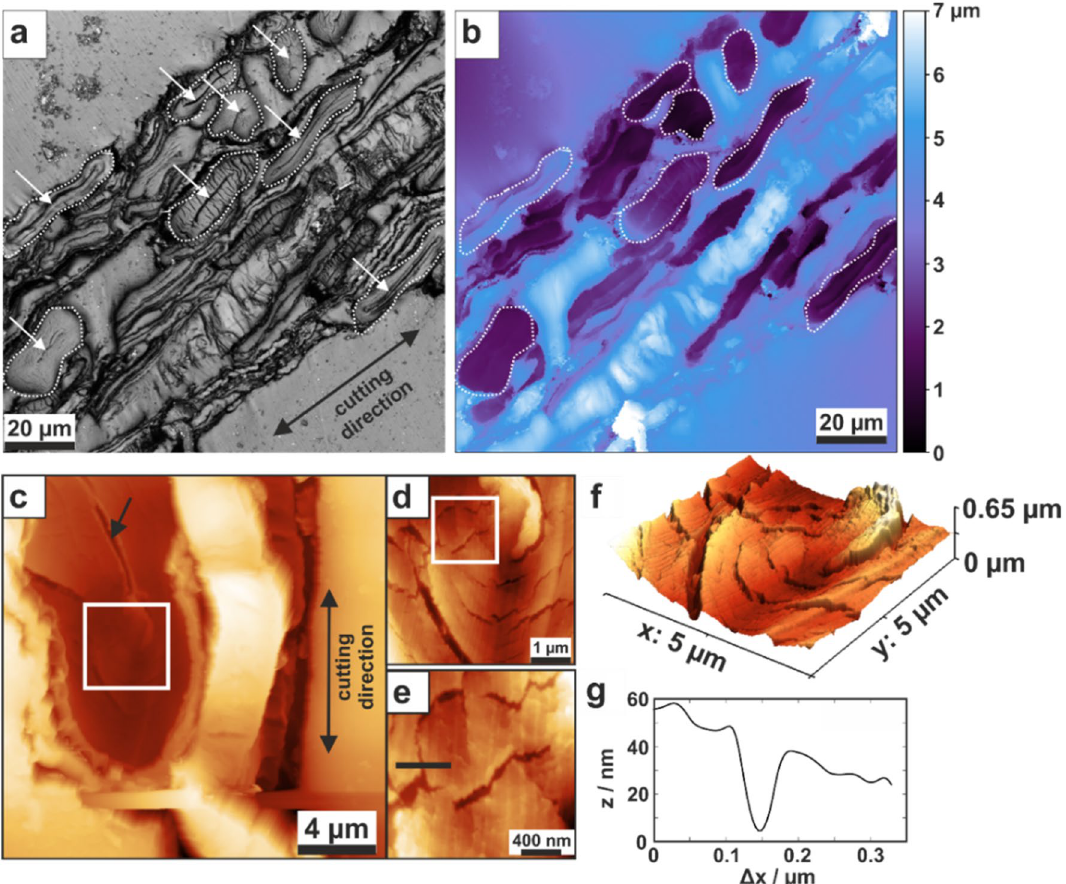
Figure 2. ( a , b ) Confocal laser scanning microscopy (CLSM) images of the surface of a microtome-cut slice of paper. ( a ) Laser intensity image and ( b ) corresponding height image. The white contours mark fiber cross- sections suitable for indentation. Each arrow in ( a ) indicates a collapsed lumen of a fiber. ( c – f ) AFM topography images. ( c ) 20 × 20 μm 2 topography image of a fiber cross-section cut perpendicular to the longitudinal fiber axis (z-scale: 4 μm). The black arrow points at the collapsed lumen, and the white squares indicate the zoom-in regions. Zoom-ins: ( d ) 5 × 5 μm 2 topography image (z-scale: 650 nm) and ( e ) 1 × 1 μm 2 topography image (z-scale: 300 nm). The black line indicates a cross-section to determine the width and depth of a crack, which is illustrated in ( g ). ( f ) 3D representation of the topography image in ( d ). ( g ) Cross-section of a crack indicated by the black line in ( e